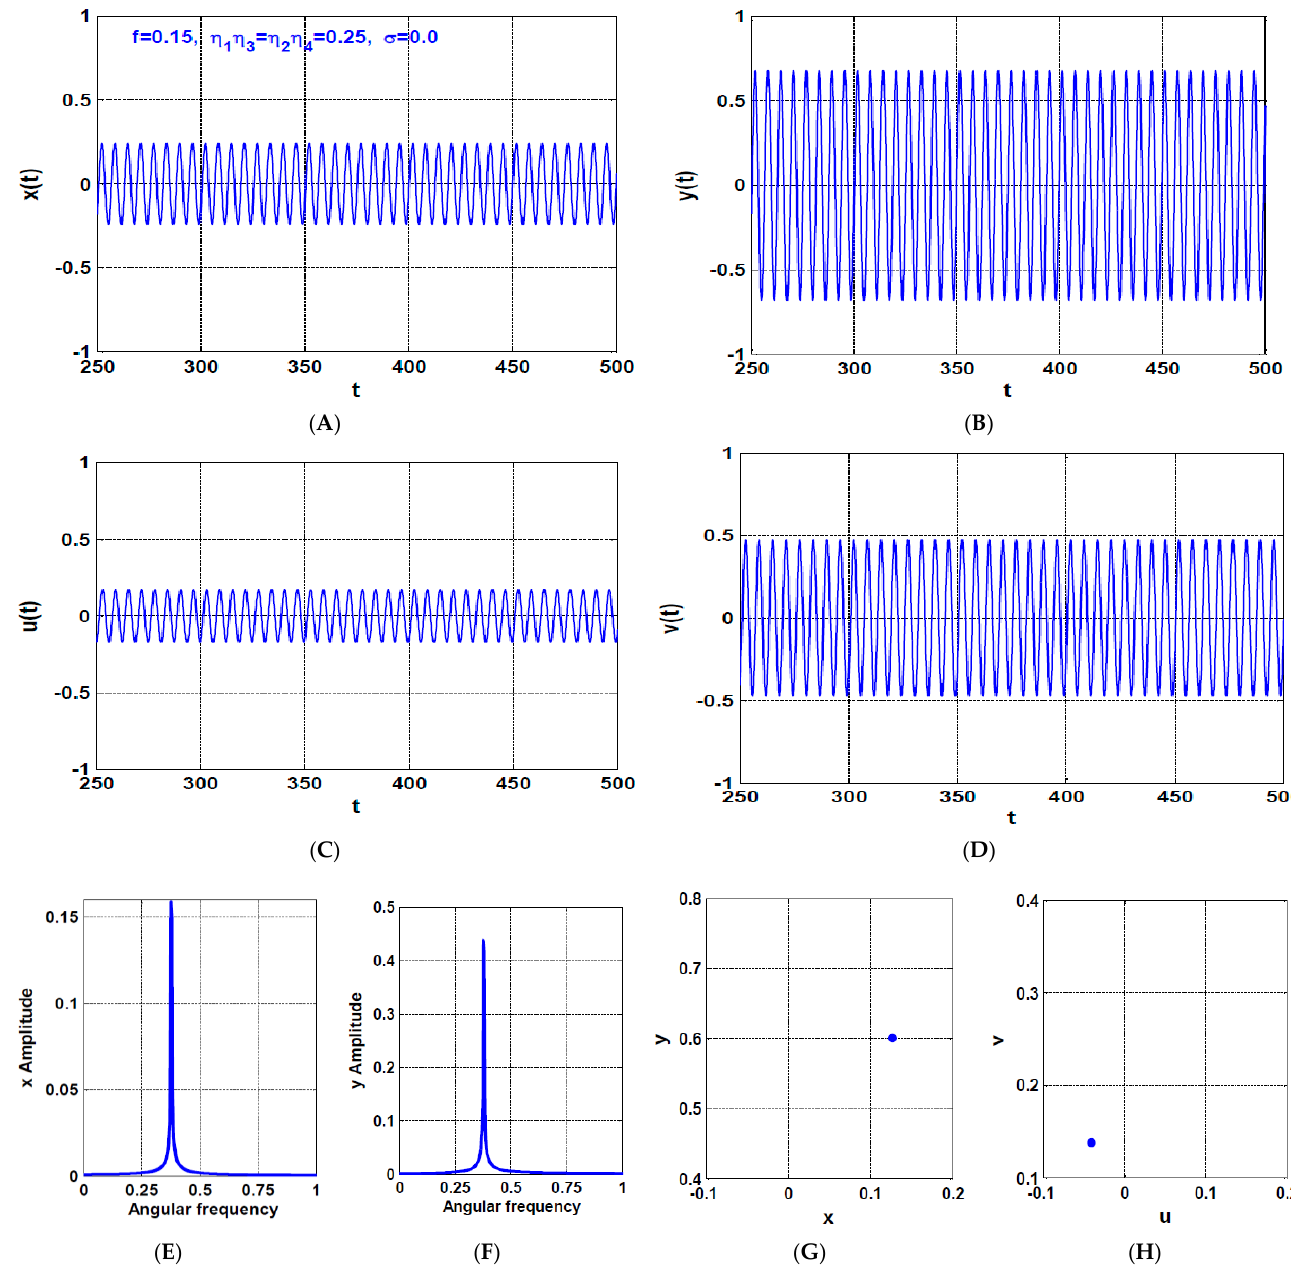
Figure 20. The rotor system steady-state time-response according to the point p 1 shown in Figure 18A (i.e., when f = 0.15, η 1 η 3 = η 2 η 4 = 0.25): ( A , B ) temporal oscillation in X and Y directions, respectively, ( C , D ) temporal oscillations of the U-IRC and V-IRC, respectively, ( E , F ) frequency spectrum, ( G , H ) the corresponding Poincaré map.